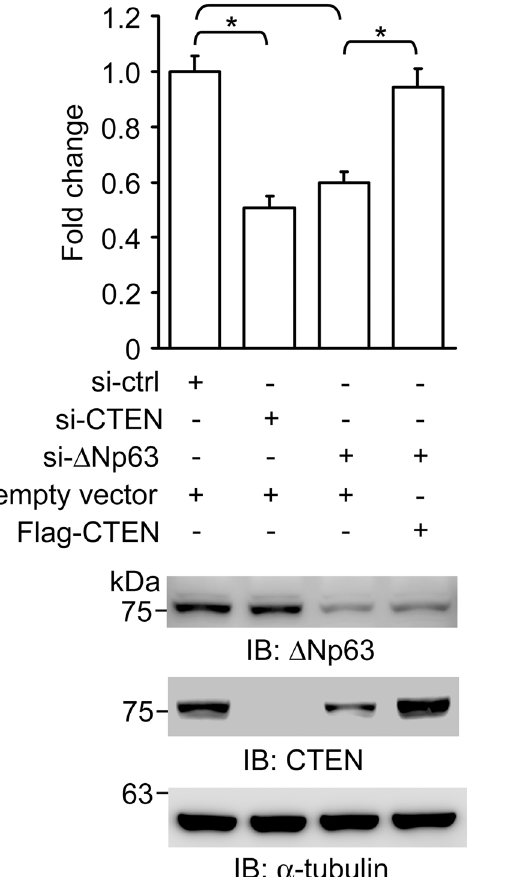
Fig 5. Expression of CTEN rescues impaired cell adhesion caused by Δ Np63 deficiency. RWPE-1 cells were transfected by control siRNA (si-ctrl), CTEN-specific siRNA (si-CTEN) or Δ Np63-specific siRNA (si- Δ Np63) together with FLAG-tagged CTEN expression plasmids (Flag-CTEN) or the corresponding empty vector. Cells were reseeded on plates coated with fibronectin 48 hr after transfection. Non-adherent cells were washed off by PBS and adherent cells were stained, solubilized and quantified by measuring the absorbance at 595 nm as described in materials and methods. The absorbance from each sample was normalized to that from the control (si-ctrl +; empty vector +) (upper panel). The final value is expressed as the mean relative fold change compared to the control. Data are expressed as the mean ± standard deviation of three different experiments analyzed in triplicate. ( * : P < 0.005) Western analyses of Δ Np63 and CTEN expression were performed 48 hr after transfection. α -tubulin was used as a loading control. (lower